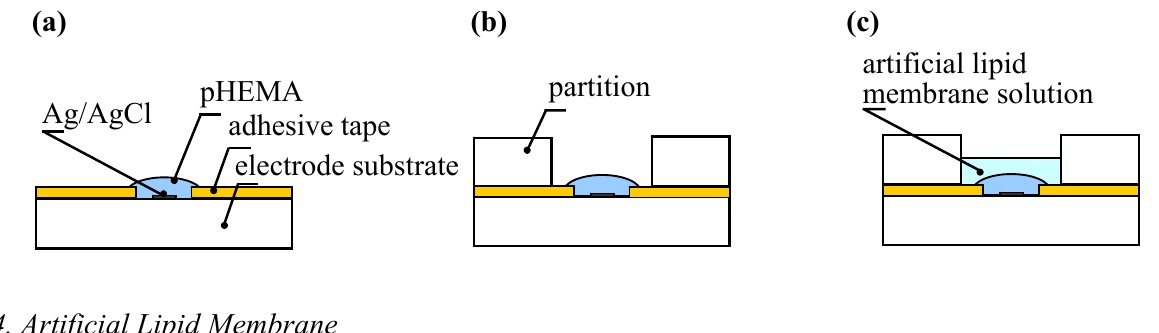
Figure 2. Manufacturing procedure for taste sensing site. (a) Forming the electrolyte layer. (b) Setting of the partition. (c) Deposition of artificial lipid membrane solution.